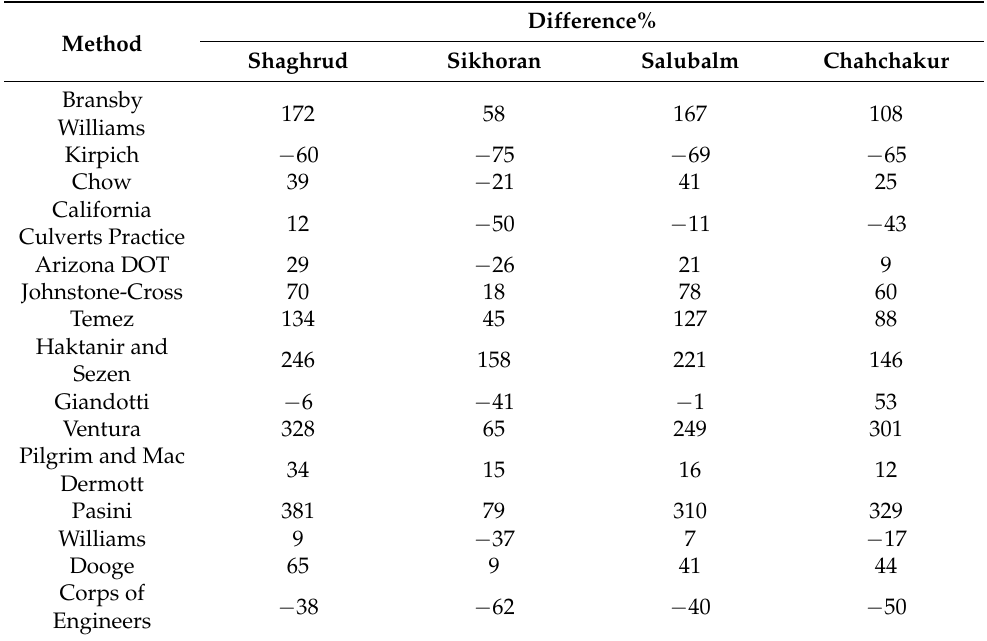
Table 6. Relative differences between mean Tc achieved by the graphical method and by empiri- cal